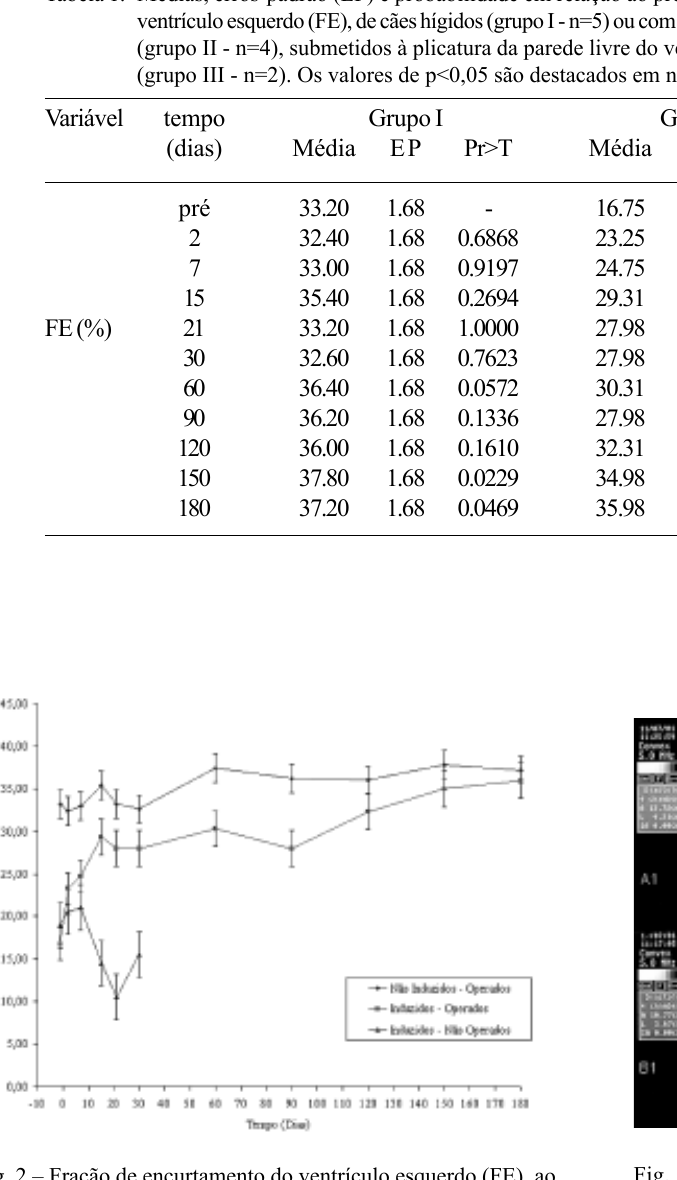
Tabela 1. Médias, erros-padrão (EP) e probabilidade em relação ao pré-operatório (Pr>T) da fração de encurtamento do